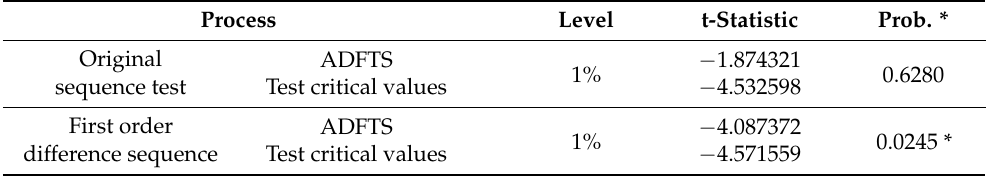
Figure 7. Trend diagram of predicted value (variable B). Table 7. Unit root test results of actual values (variable